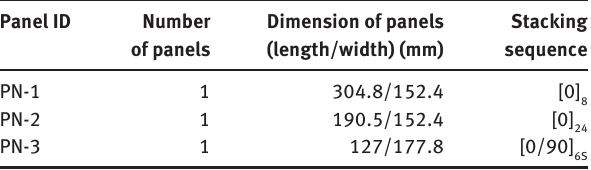
Table 2: Test panel configurations.